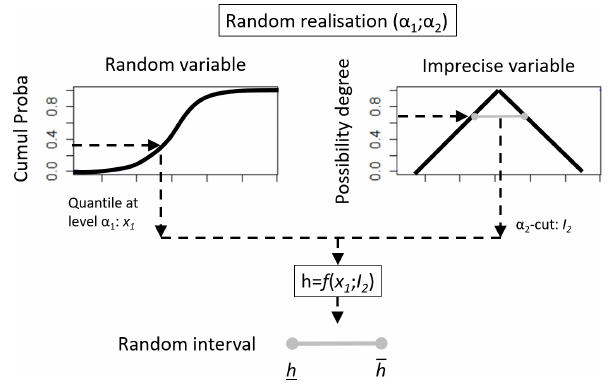
Figure A1. Overview of the main steps for joint propagation of possibility and probability distributions. Adapted from Rohmer and Verdel